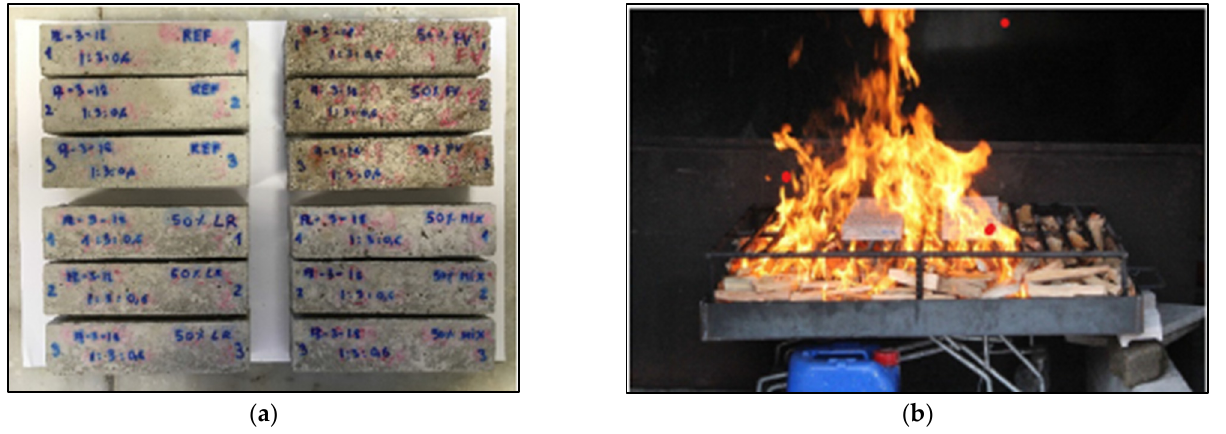
Figure 11. Fire ‐ resistance of cement mortars: ( a ) specimens and ( b ) fire test. Figure 11. Fire-resistance of cement mortars: ( a ) specimens and ( b ) fire